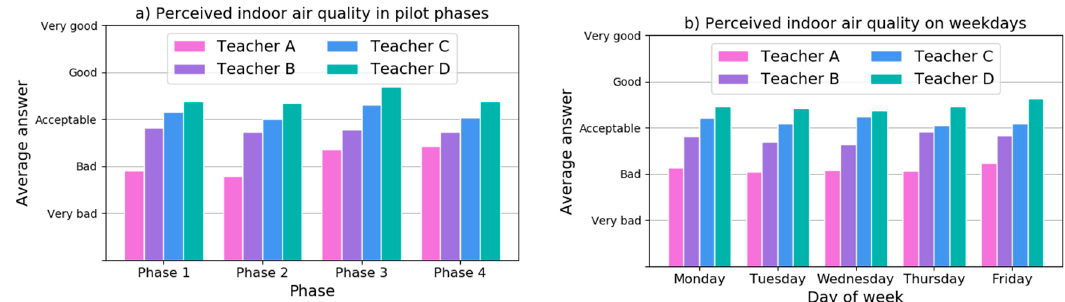
Figure 3. ( a ) Average answers for perceived indoor air quality question during different pilot phases. ( b ) Average answers for perceived indoor air quality question on different weekdays.